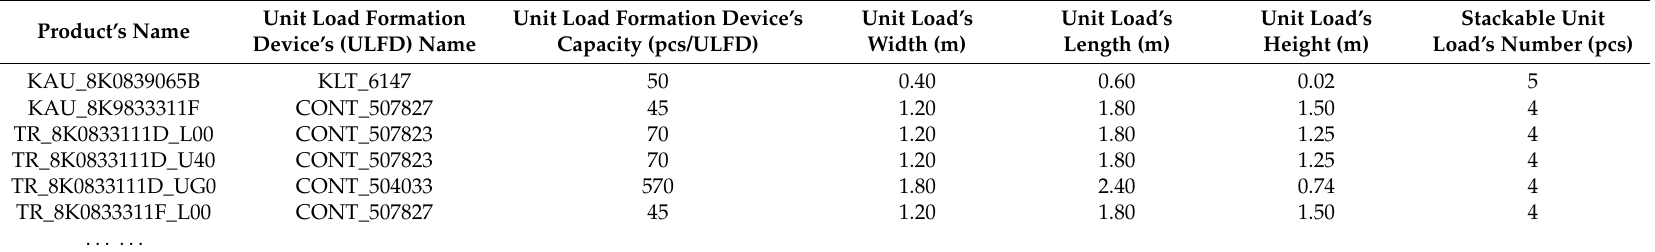
Table 8. Unit load (UL) data table.